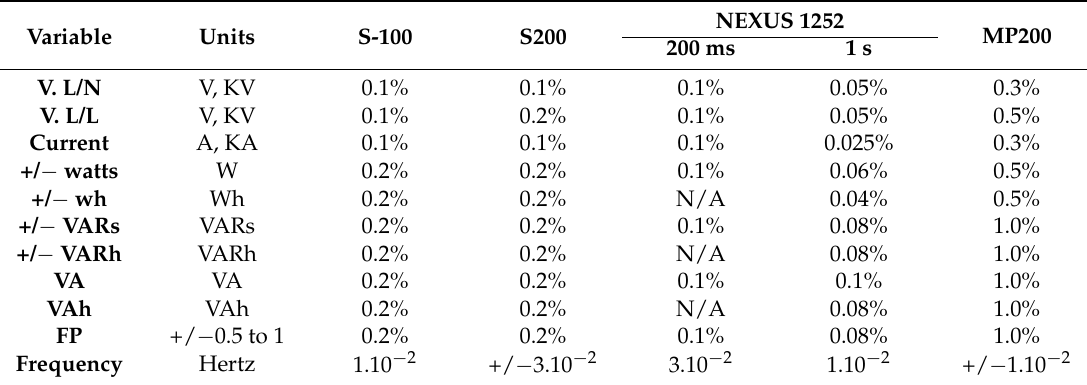
Table 1. The variables accuracy for each